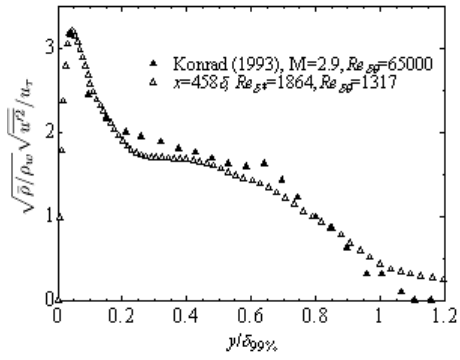
Fig. 7 Streamwise velocity fluctuation in supersonic boundary